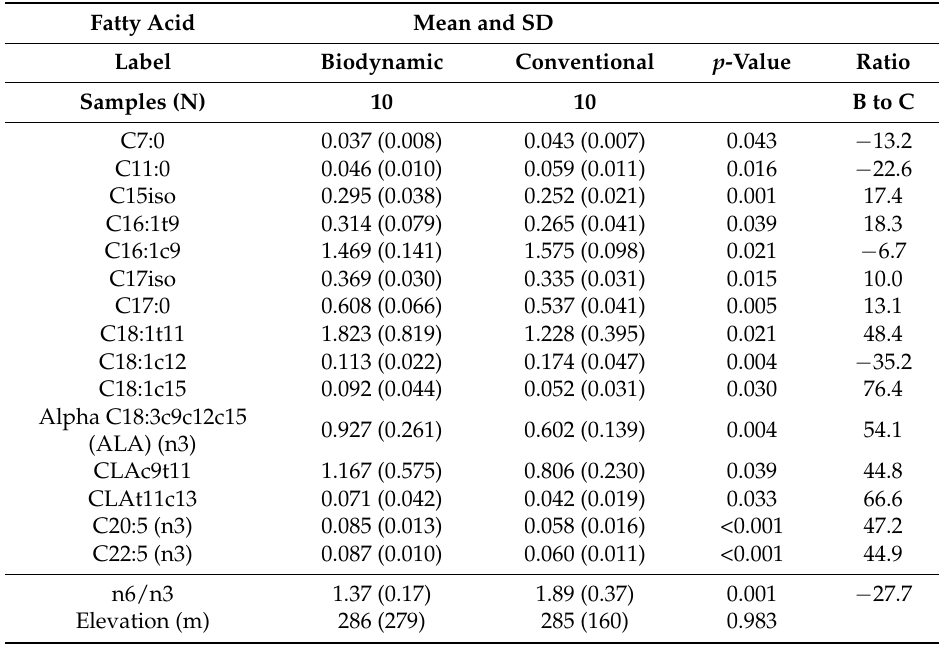
Table 7. Significantly different single fatty acids in the summer shop milk of biodynamic and conventional creameries in several European regions based on a paired T -test, and the ratio of biodynamic to conventional (B − C)/C × 100